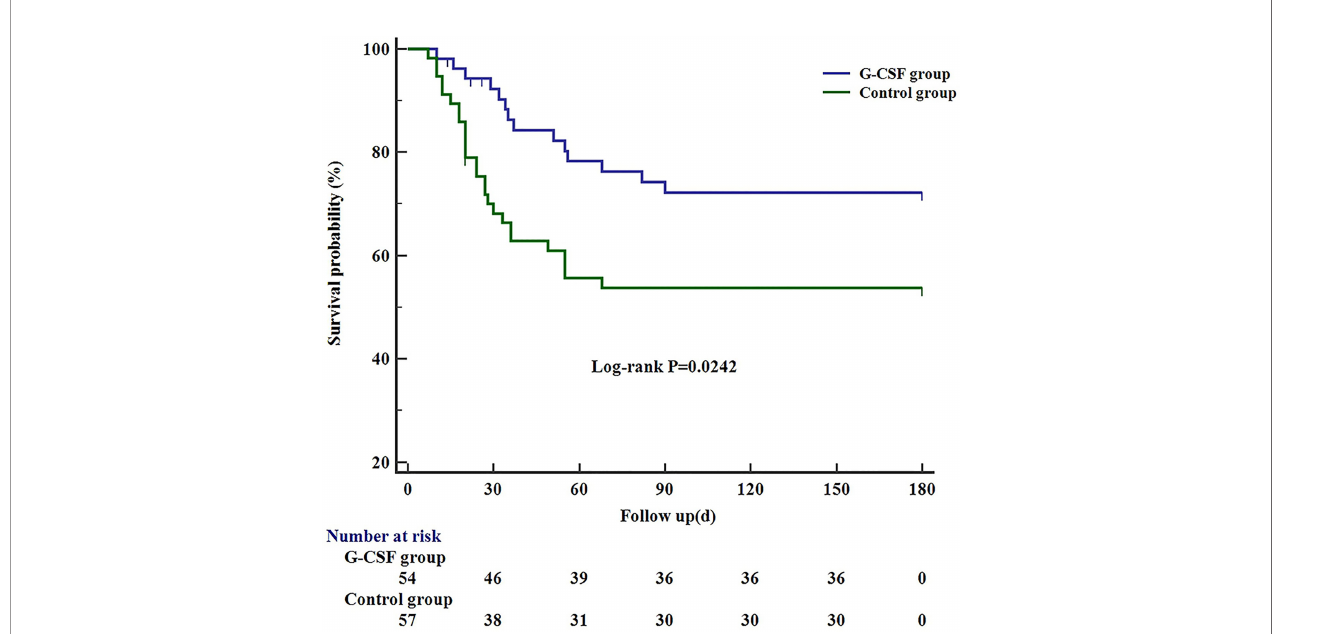
FIGURE 2 | Kaplan – Meier curve showing the 180-day survival in G-CSF group, compared with the control group. G-CSF, Granulocyte-colony stimulating